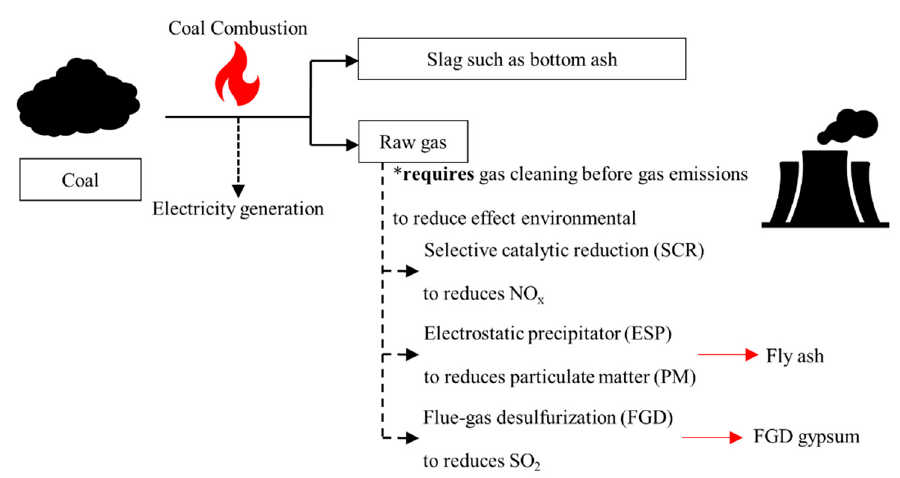
Figure 2. Pollution-control systems used to clean emissions from a coal-fired power plant.